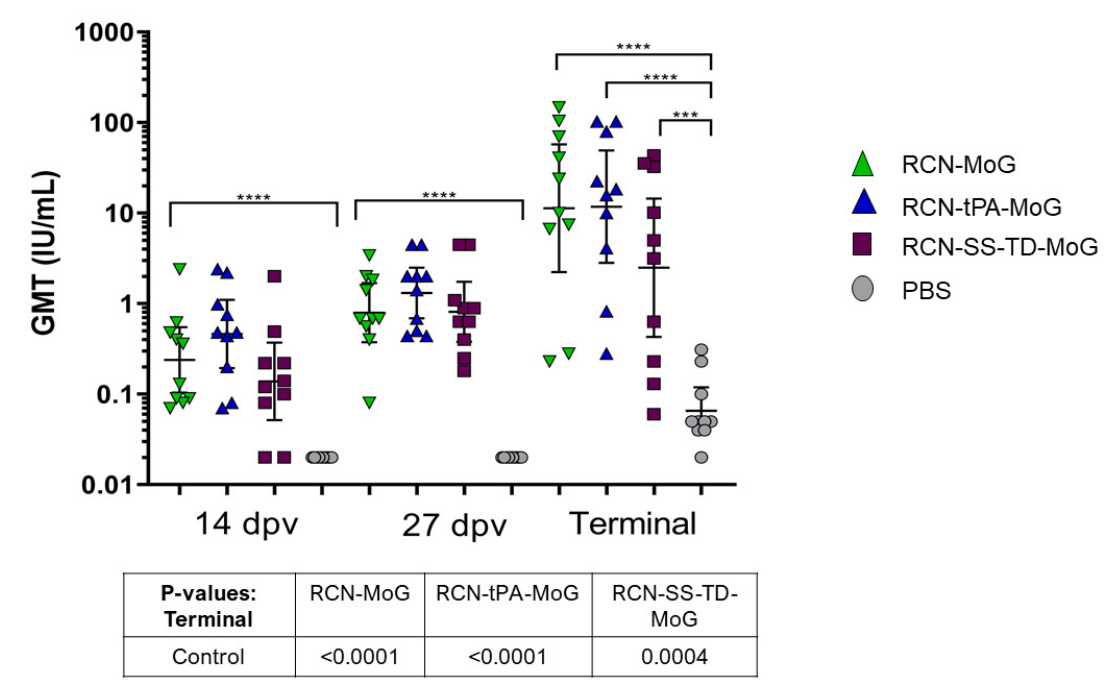
Figure 4. Geometric mean serum titers of rabies neutralizing antibodies (IU/mL) in mice 14 dpv, 27 dpv, and at the end of the study. Mice were inoculated with either RCN-MoG, RCN-tPA-MoG, RCN-SS-TD-MoG, or PBS. No significant differences were observed between vaccinated groups at any time point ( p > 0.05). Significant differences were detected between vaccinated and control groups at each time point (p ≤ 0.0001, except for RCN-SS-TD-MoG group at end of study where p = 0.0004). Asterisks on the graph indicate statistical significance (i.e., *** = p ≤ 0.001 and **** = p ≤ 0.0001).